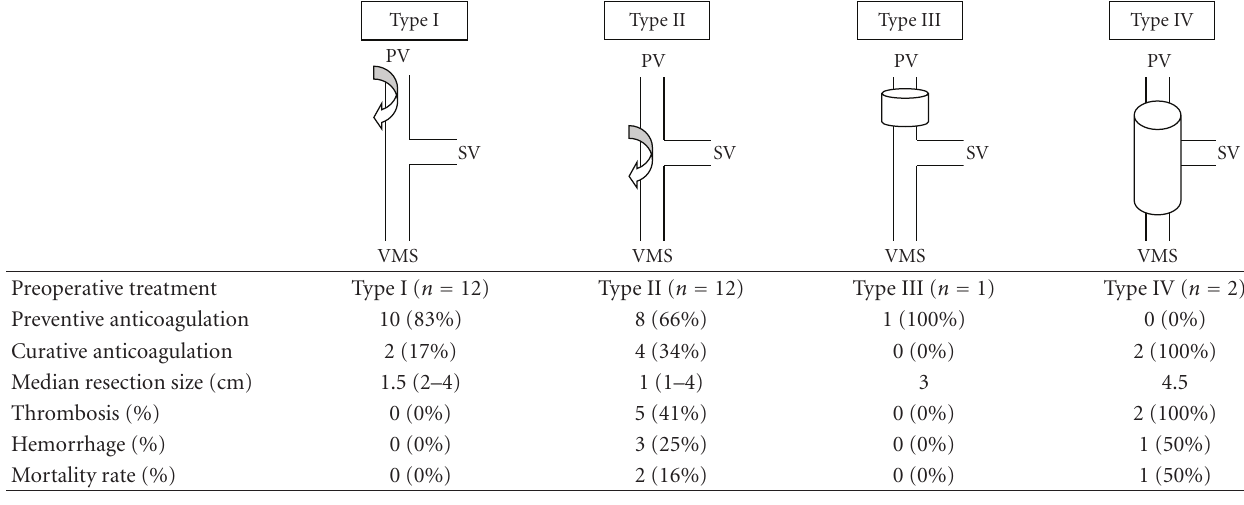
Table 1: Types of resection and anticoagulation treatment associated with complications (hemorrhagic, thrombosis) and mortality